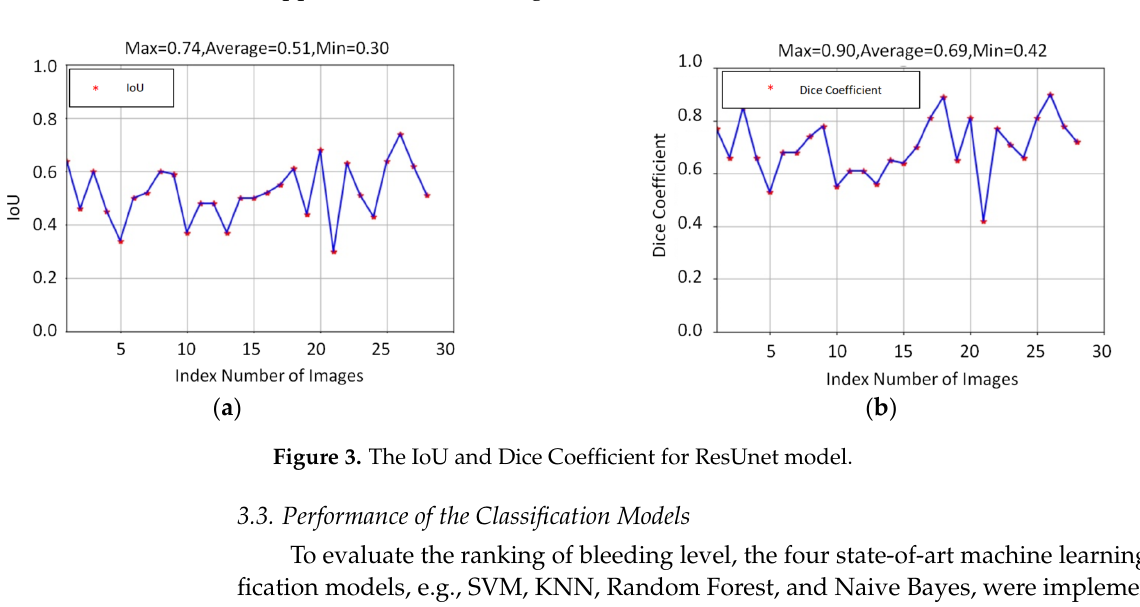
( d ) Figure 4. ( a ) Input image. ( b ) The bleeding areas of input image were extracted through YCbCr. ( c ) The image with cut- ting loop eliminated. ( d ) The image with revised bleeding areas. 3.3. Performance of the Classification Models To evaluate the ranking of bleeding level, the four state-of-art machine learning classification models, e.g., SVM, KNN, Random Forest, and Naive Bayes, were imple- mented in this study. Each ground truth of surgical video was manual label into four grades, including score 0: excellent, score 1: acceptable, score 2: slightly bad, and 3: bad. In the training stage, approximately 150 videos were selected as a training dataset for classification models. Apart from this, 10% of the training dataset was divided into vali-